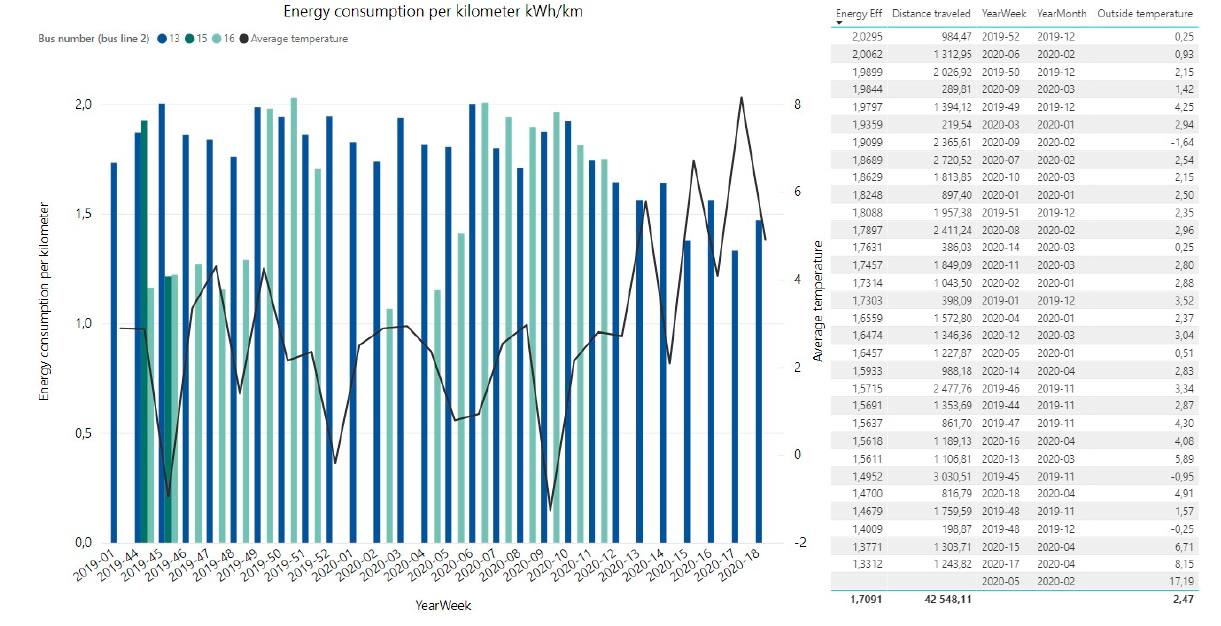
Figure 7. Energy efficiency and outside temperature per week during 1 November 2019–30 April 2020. Disclaimer: The comma is used as a decimal separator instead of a dot because the version of Power BI used in the visualization followed the grammar rules of the Finnish language.